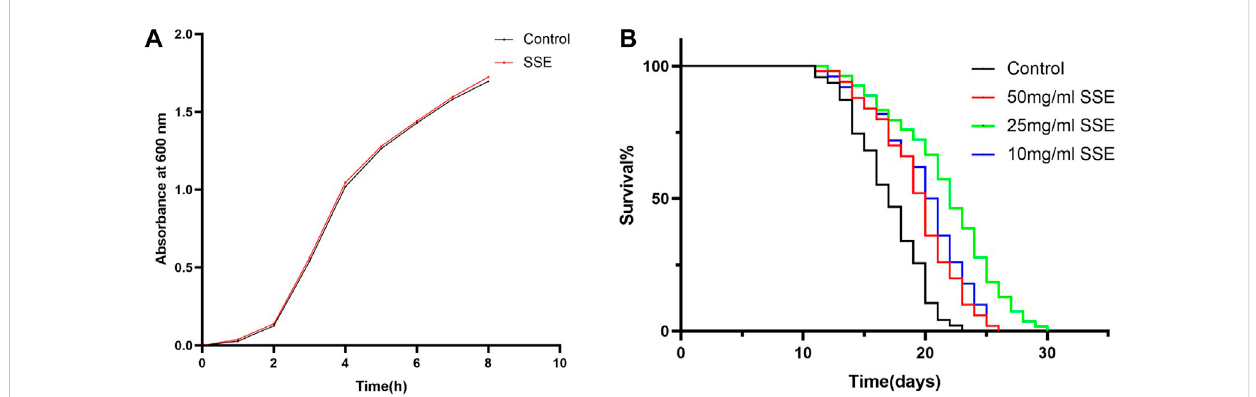
FIGURE 1 Effect of SSE on the lifespan of N2 wild-type Caenorhabditis elegans . (A) Effect of SSE on the propagation of E. coli OP50. (B) The time that the worms were fi rst treated with S. Sanghuang was recorded as day 0; SSE treatments noticeably prolonged the survival times of nematode ( p < 0.05). The experiment was repeated at least three times.